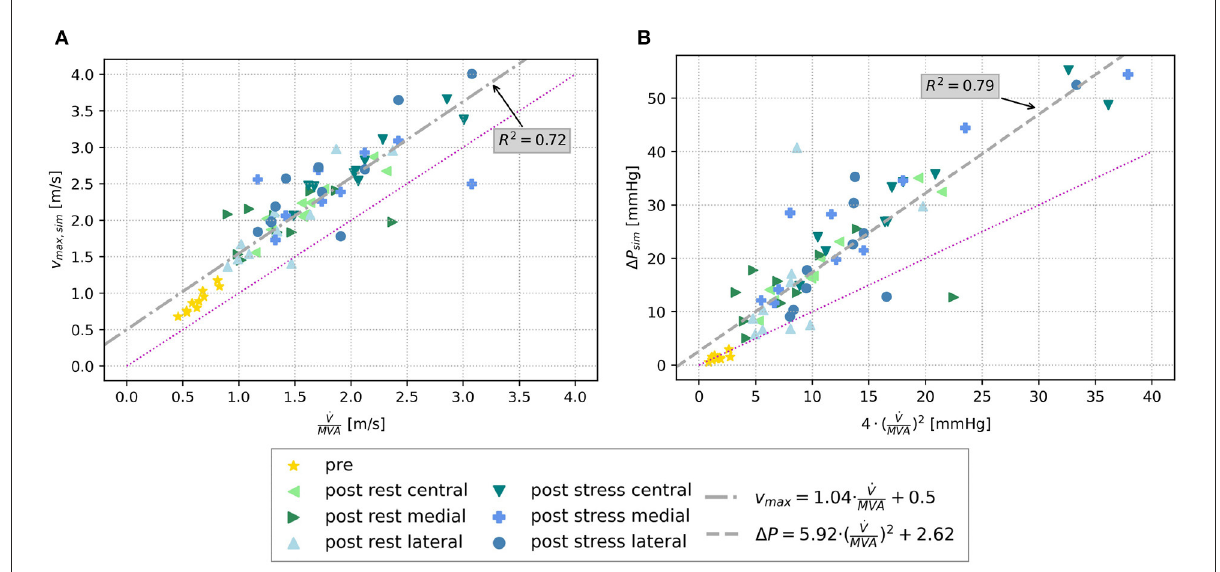
FIGURE8 (A) Scatter plot of simulated maximal velocities pre and post virtual TEER at rest and stress, respectively, over the estimated maximal velocity using volume flow and MVA. (B) Scatter plot of simulated MPG ( 1 P ) over the estimated MPG by means of the simplified Bernoulli-Equation (Equation 4). The bisector is indicated by the magenta line in both plots, and a regression line is drawn in gray.